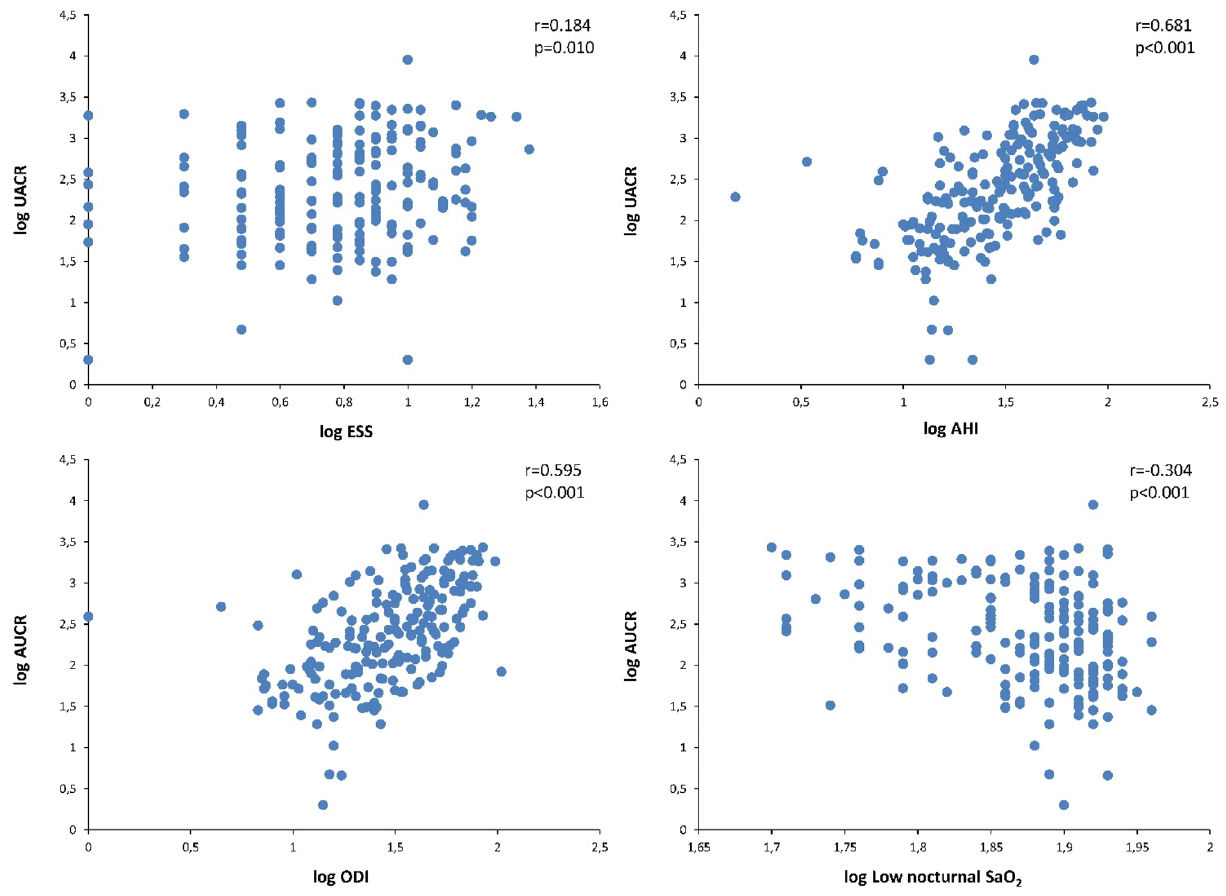
Figure 2. Relationship between the sleep characteristics and the urinary albumin–creatinine ratio (UACR) in patients with diabetic kidney disease. Data are log transformed. ESS Epworth sleepiness scale, AHI apnea– hypopnea index, ODI desaturation index, SaO 2 oxygen